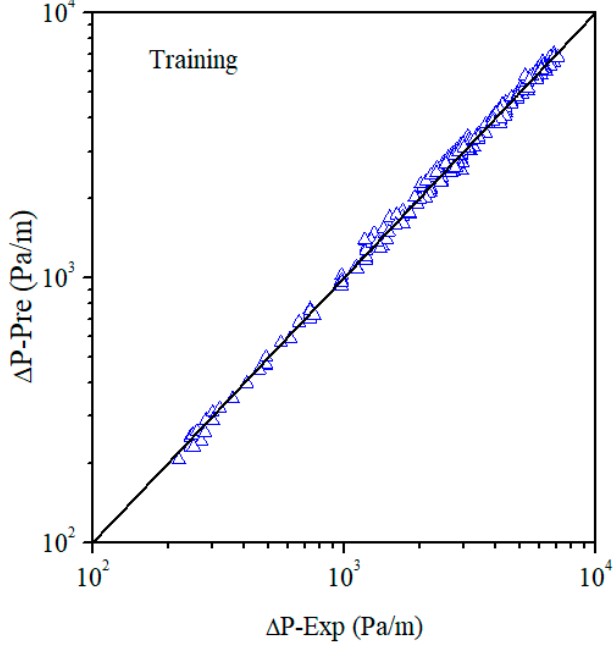
Figure 5. Comparison of predicted pressure drop with experimental values of training dataset.